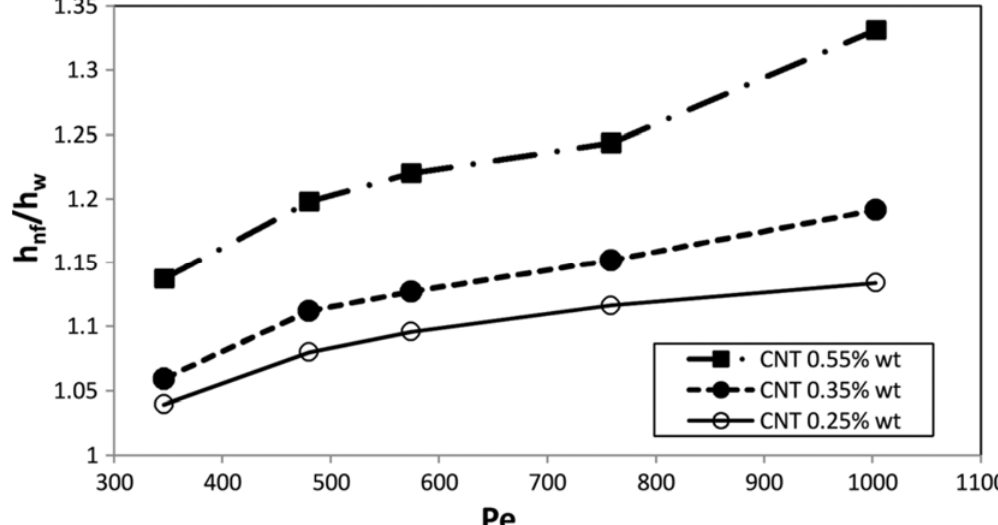
Figure 9. Variations of relative convective heat transfer coefficient versus Peclet number in different solid concentrations. Reproduced with permission from [180]. Taylor & Francis, 2015.